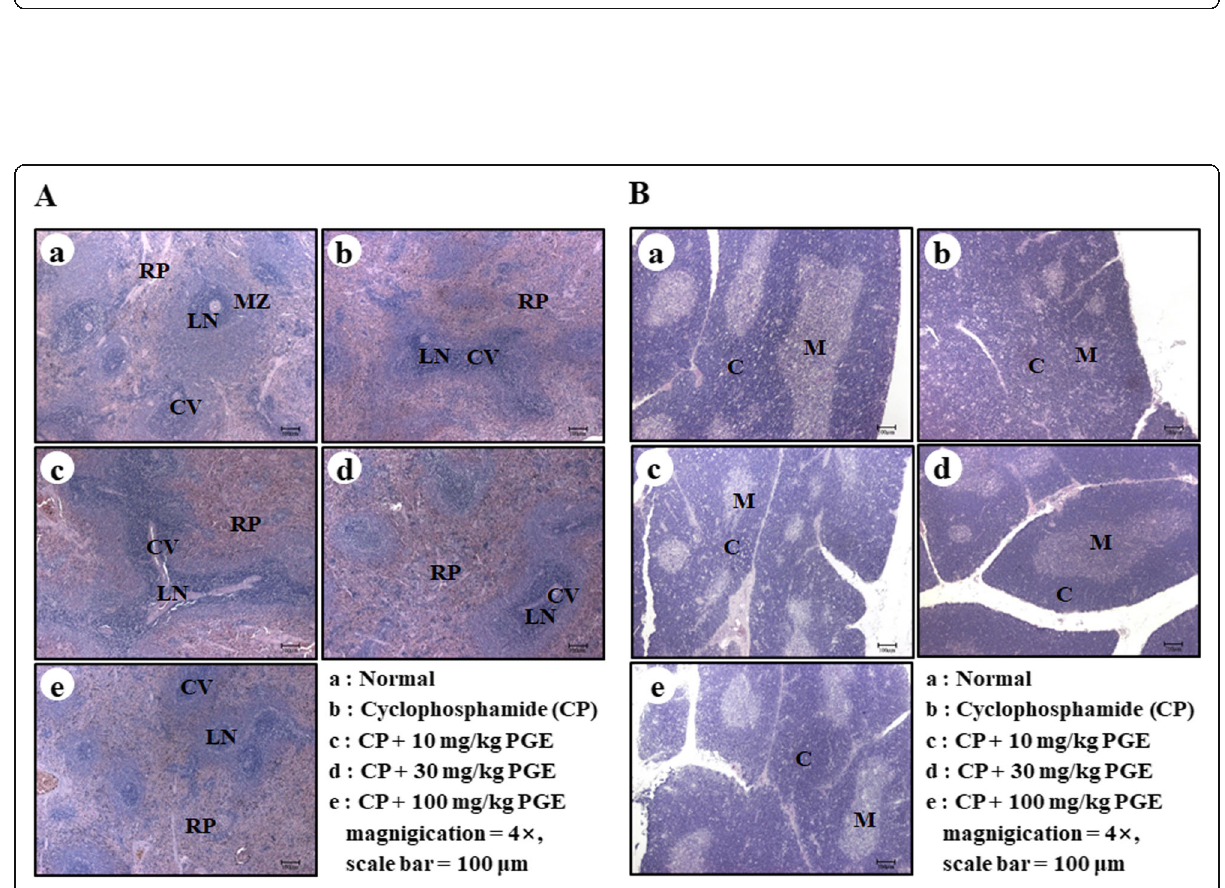
Fig. 8 Effect of PGE on plasma levels of immunoglobulins in the sera of CP-induced immunosuppressed rats. Rats were given saline, CP (5 mg/ kg/day), and PGE (0, 10, 30, or 100 mg/kg/day) once daily for 28 days, after which the serum levels of IgG ( a ) and IgA ( b ) were quantified using ELISA kits. Bars labeled with different superscripts have significantly different values ( P < 0.05). Data are presented as the means ± standard errors ( n = 7)